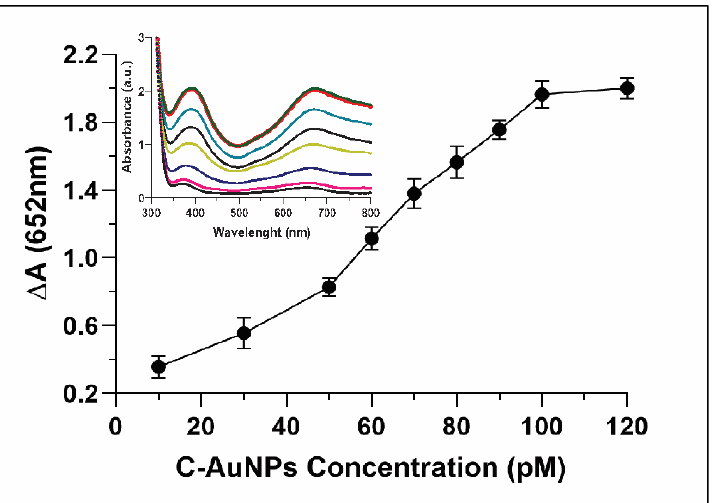
Figure 6. Explicate the catalytic activity of C-AuNP increasing with increasing concentrations. Inset represents the UV-Vis spectra of C-AuNPs and TMB with growing concentrations of C-AuNPs.